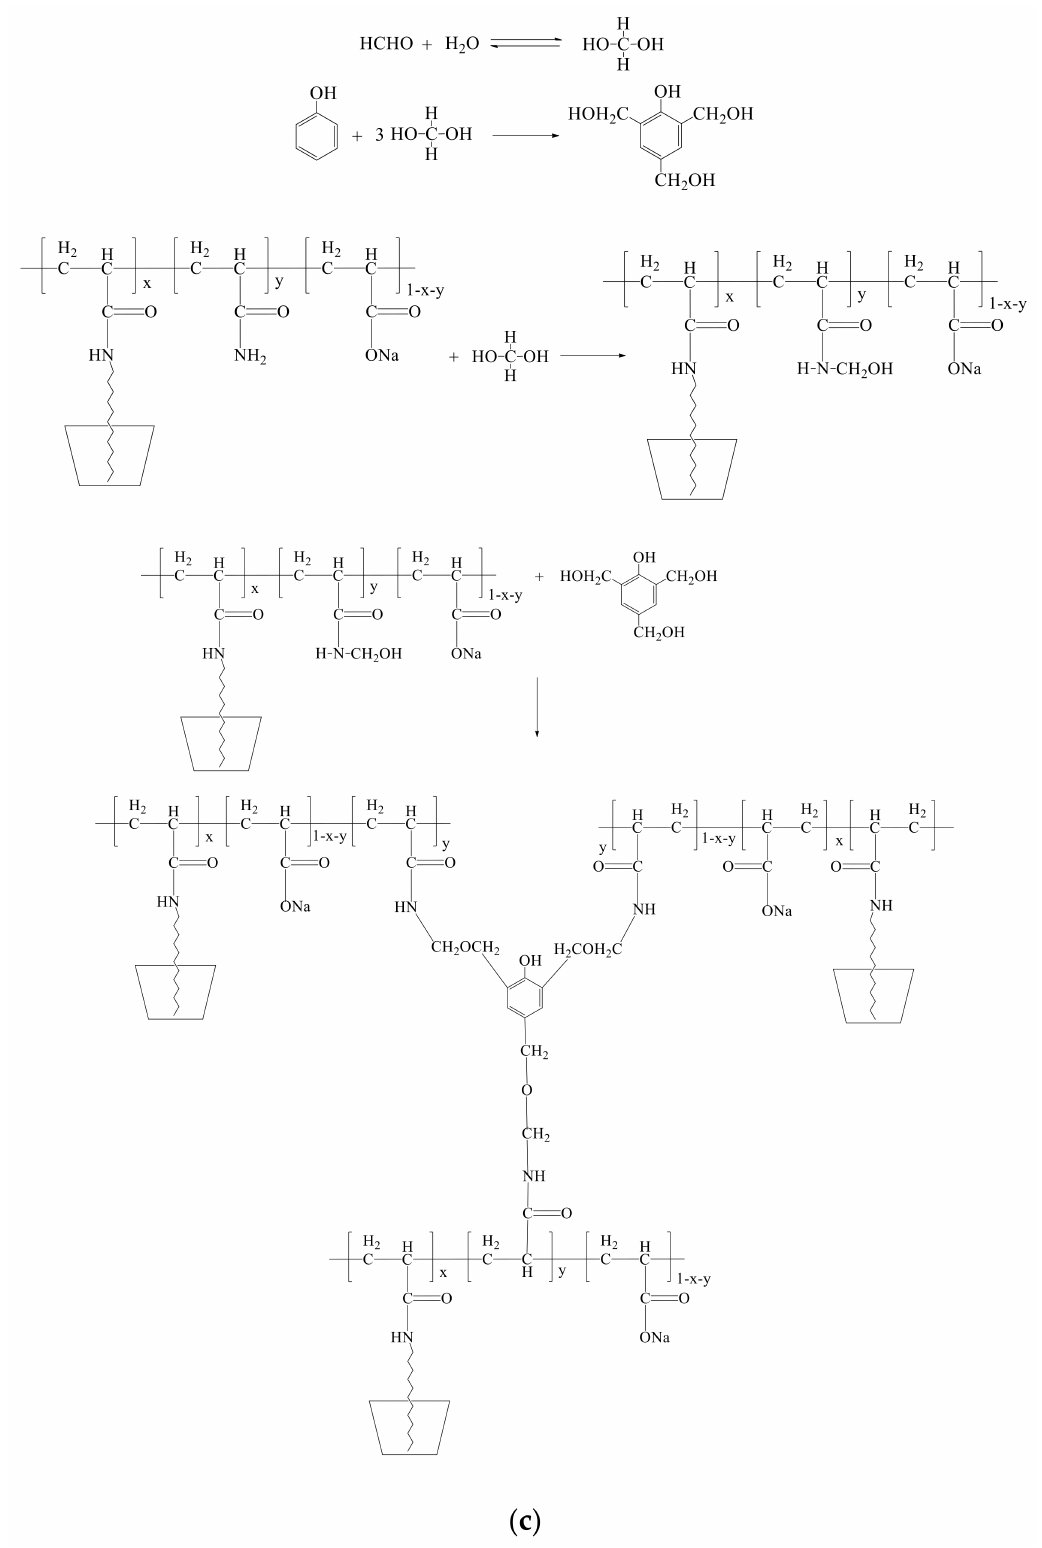
Figure 9. The probable gelation mechanism of the delayed crosslinking amphiphilic polymer gel system based on competitive inclusion method. ( a ) Controlled release of phenol in the presence of amphiphilic polymer; ( b ) formaldehyde release from methenamine; ( c ) gelation mechanism of the HMPAM/phenolic resin gel